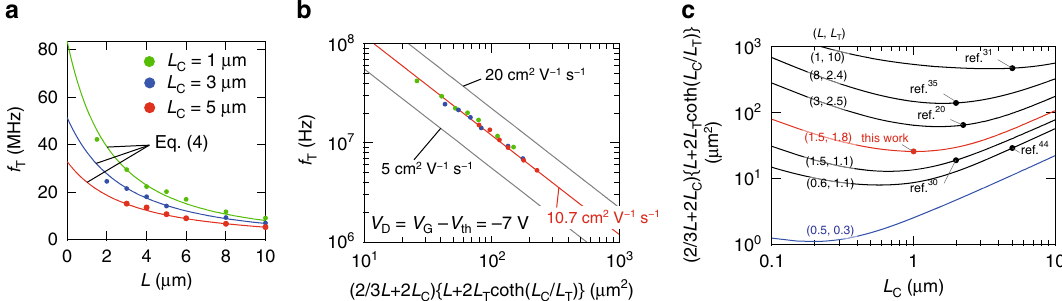
Fig. 5 Correlation of the static and dynamic electrical performances of the OFETs. a Dependence of f T on L with various values of L C . Solid curves represent theoretical f T values derived from Eq. (4). b Dependence of f T on the OFET areal factor ð 2 data with μ int = 10.7 cm 2 V − 1 s − 1 . c Dependence of the areal factor on L C with various combinations of L and L T . Values in parentheses represent L and L T . Solid curves indicate the theoretical areal factors that are uniquely de fi ned when three length parameters are given. Red curve: data calculated with the experimentally determined values of L and L T . Black curves: data calculated using L and L T values estimated from previous studies. Blue curve: data that reproduces the areal factor of 1 μ m 2 . Circles plotted on each curve represent the experimentally obtained areal factors. Areal factors are adapted from references: 472 μ m 2 ( f T = 2.2 MHz) for Ante et al. (Max Planck group) 31 , 140 μ m 2 (no f T data) for Borchert et al. (Max Planck group) 35 , 63 μ m 2 ( f T = 20 MHz) for Yamamura et al. (this group) 20 , 29 μ m 2 ( f T = 21 MHz) for Borchert et al. (Max Planck group) 44 , 26 μ m 2 ( f T = 45 MHz) for this work,